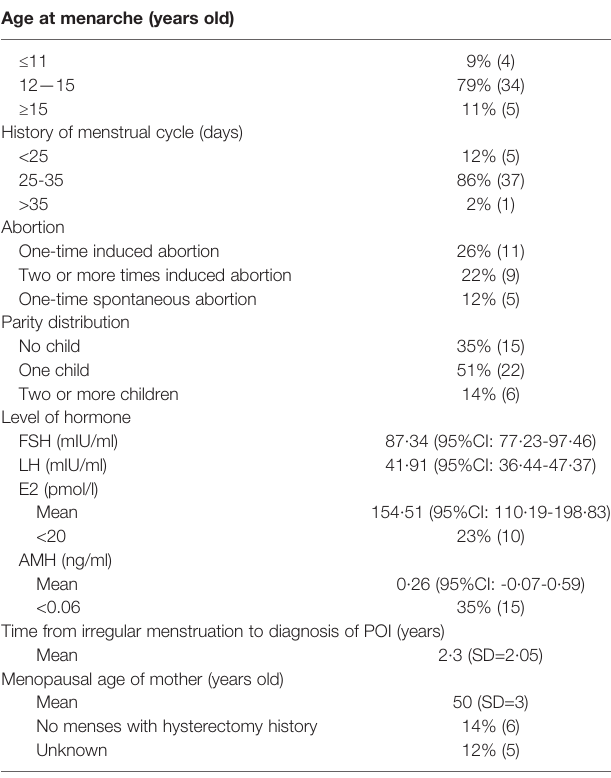
FSH, follicle-stimulating hormone; LH, luteinizing hormone; E2, estradiol; AMH, anti- müllerian